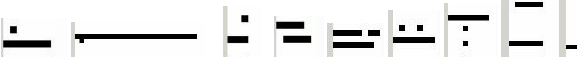
Figure B.1. Examples of line plus dot patterns caused by noisy photodiodes. Fig. B1. Examples of line plus dot patterns caused by noisy photo-